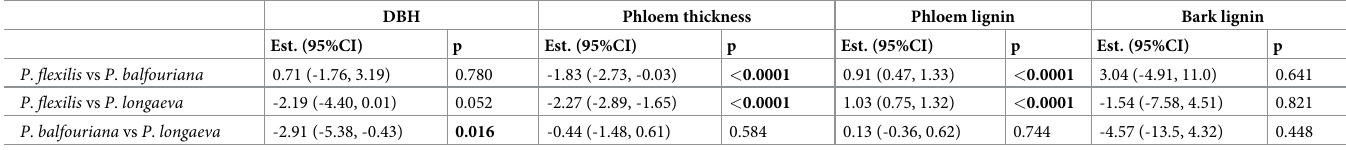
Table 2. Model estimates testing for species differences in diameter at breast height (DBH; cm), phloem thickness (mm), and phloem and bark lignin concentra- tions (mg/g FW) among P . flexilis , P . balfouriana , and P . longaeva . DBH Phloem thickness Phloem lignin Bark